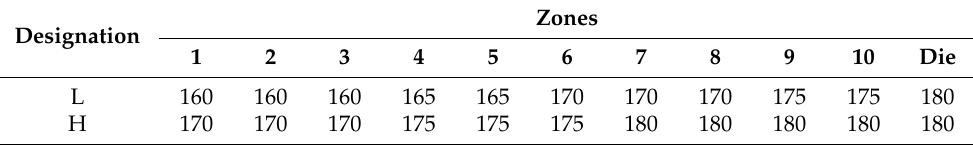
Table 4. Temperature profiles of the twin-screw extruder (temperature values are shown in ◦ C).